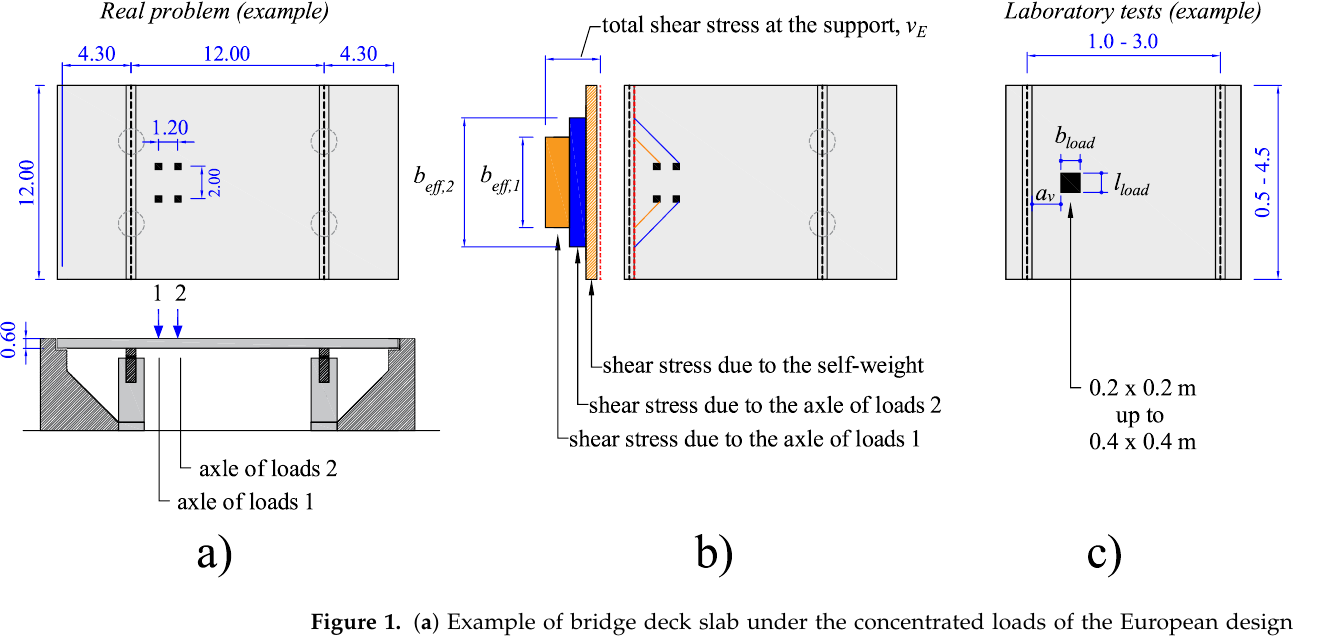
Figure 1. ( a ) Example of bridge deck slab under the concentrated loads of the European design tandem; ( b ) example of calculation of the design shear stress v E at the support combining the actions from the self-weight and the ones from the load axes using the effective shear width definition; ( c ) example of laboratory test.